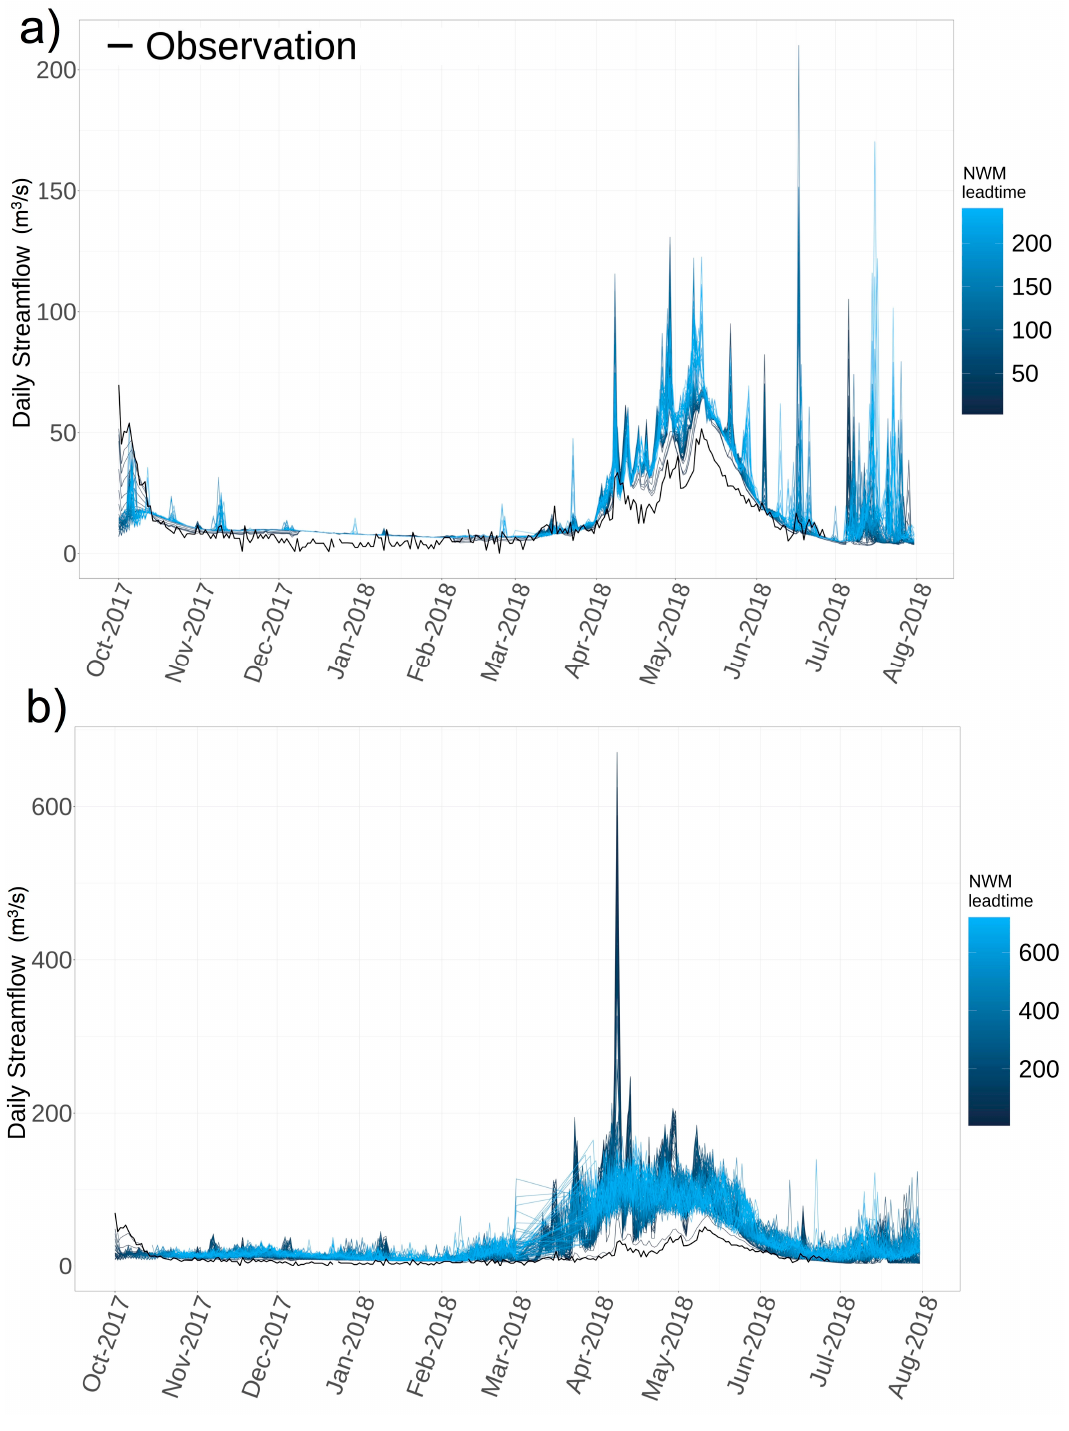
Figure A4. NWM simulated reservoir inflows into Navajo Dam for a one − year forecast period for medium ( a ) and long range ( b ). Blue lines are the modeled flows for all lead times and black is the BoR observations.